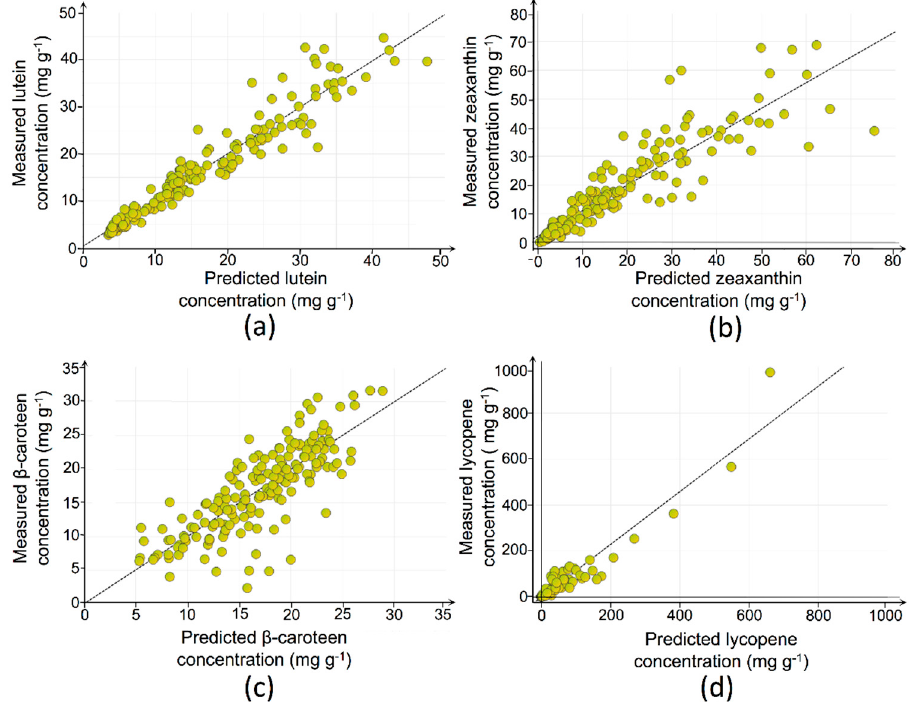
Table 2. OPLS models that were able to predict tomato fruit carotenoid concentrations based on metabolic fingerprints. Validation of these models was performed based on CV-ANOVA ( p -value < 0.05), permutation testing and three model characteristics (( R 2 ( X ), R 2 ( Y ), and Q 2 ( Y )). All of the presented models performed well for CV-ANOVA and permutation testing.